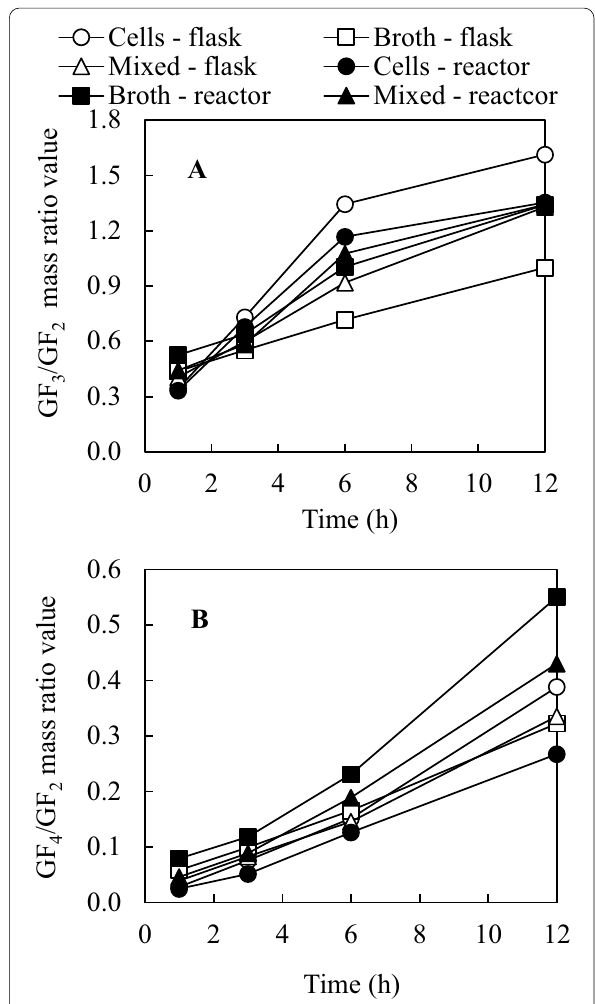
Fig. 5 Comparison of GF 3 /GF 2 and GF 4 /GF 2 ratio values using intracellular, extracellular and total enzymes from shake flasks and 1